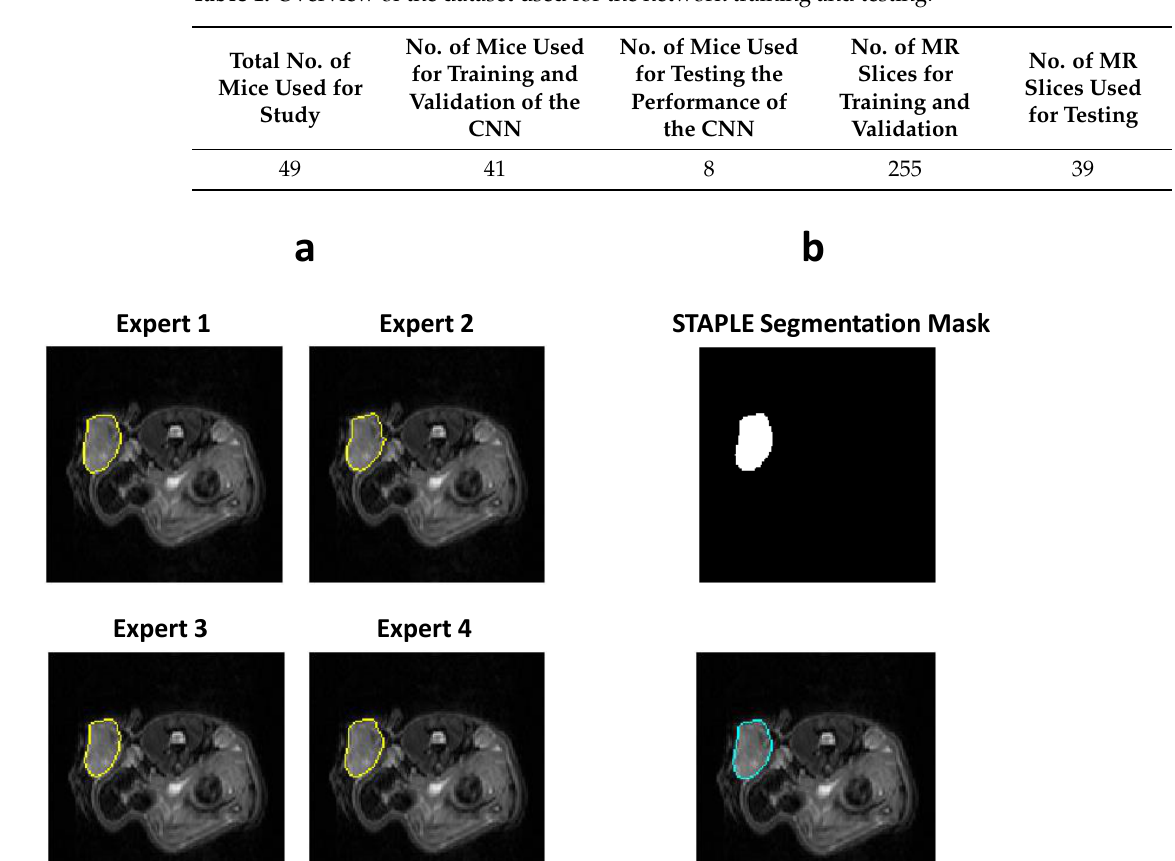
Table 1. Overview of the dataset used for the network training and testing.